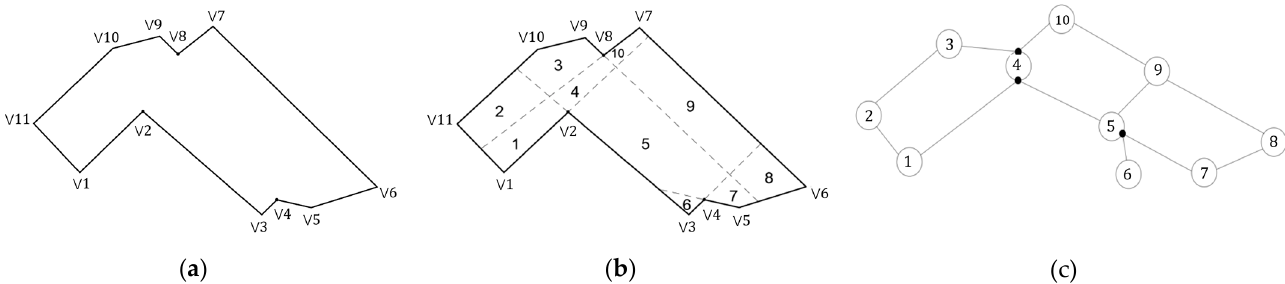
Figure 12. Decomposition of the concave polygons. ( a ) Concave polygonal area; ( b ) decomposition of concave polygonal area; ( c ) undirected graph of sub-regions.